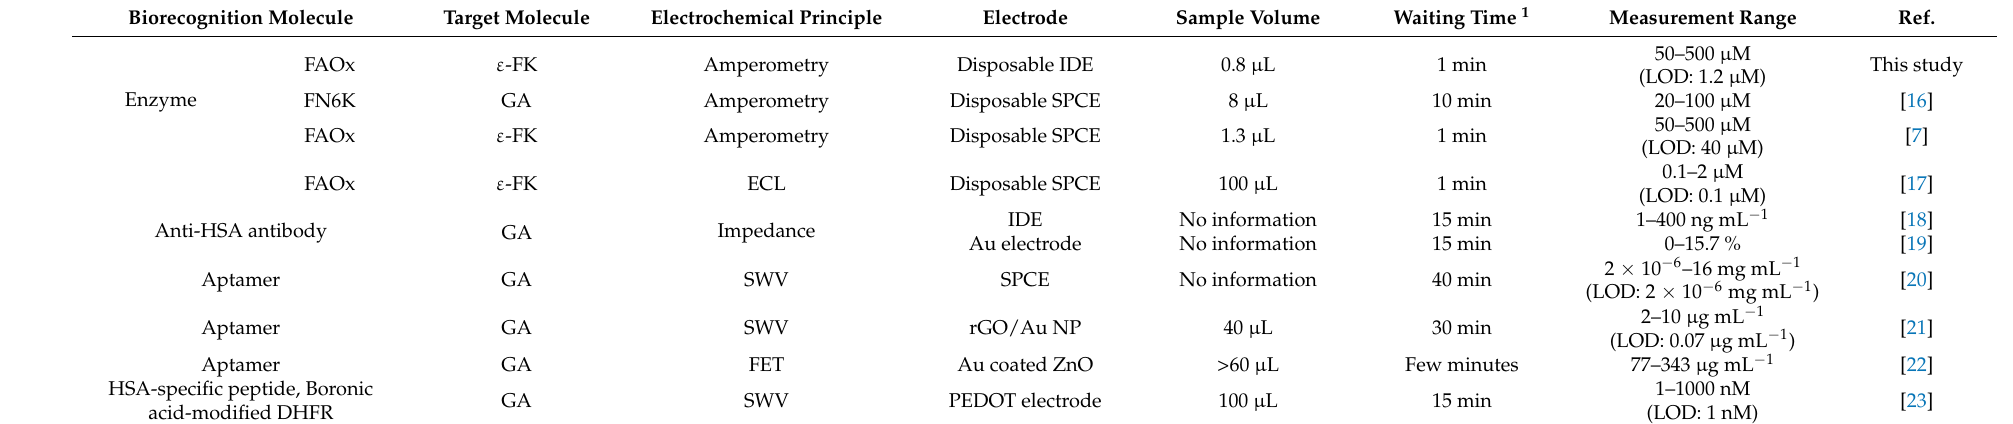
Table 1. Comparison of reported electrochemical biosensors for GA